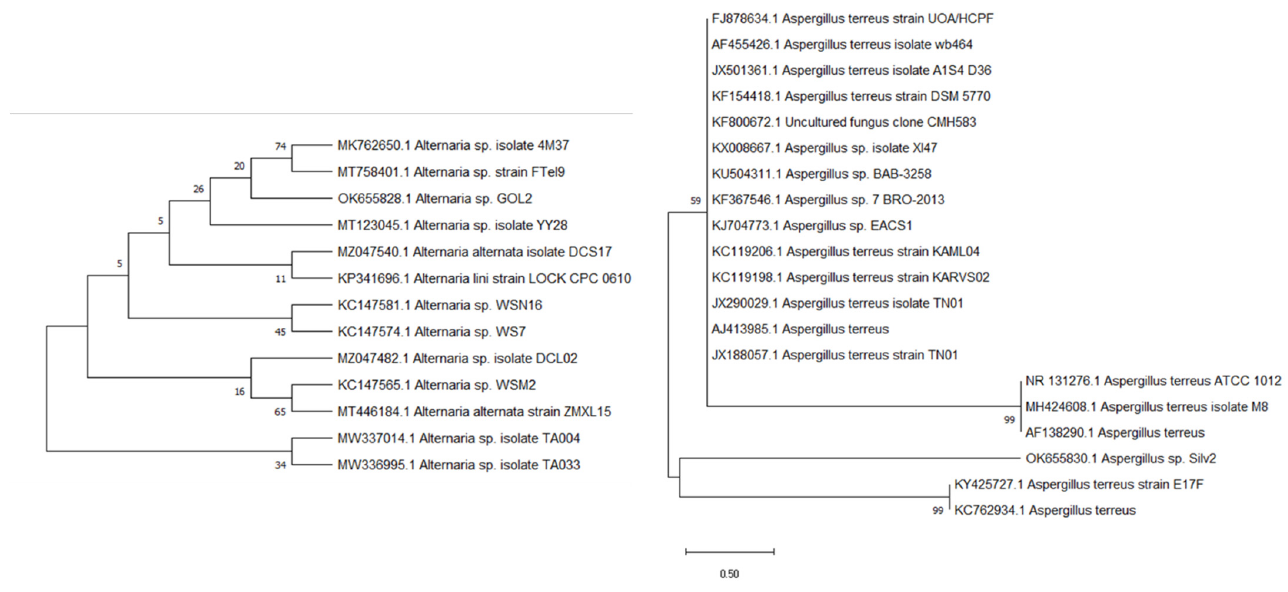
Figure 1. Evolutionary trees of the Aspergillus sp. Silv2 and Alternaria sp.